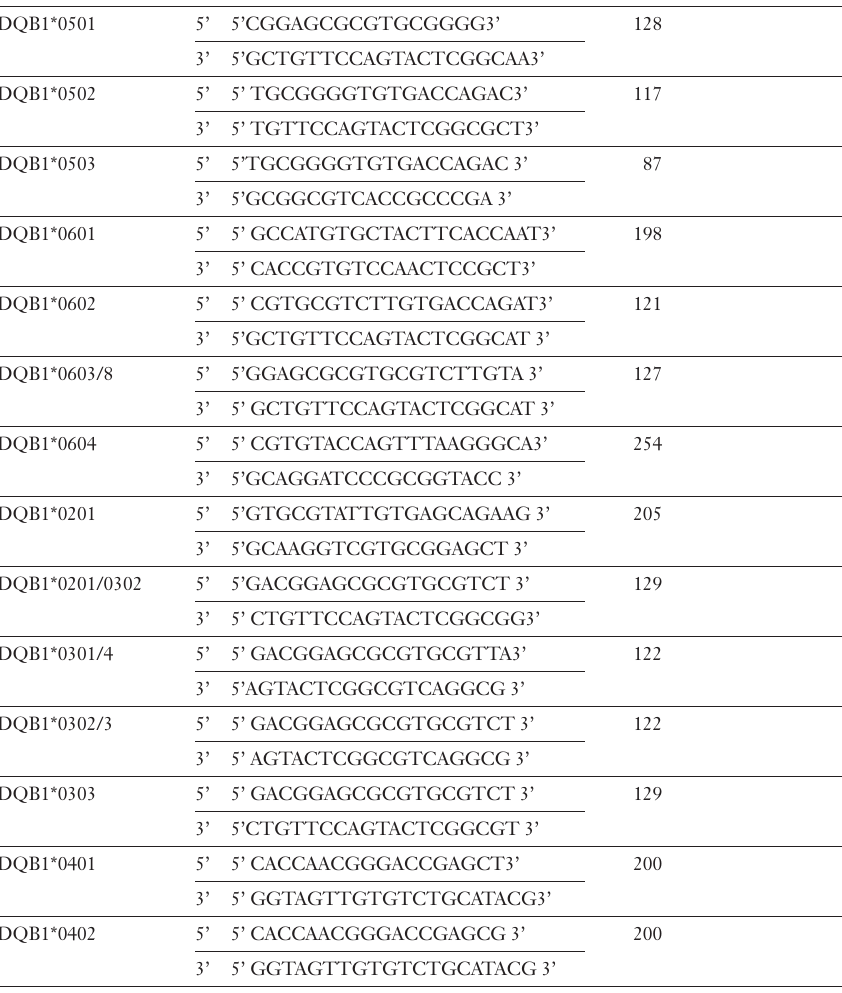
Outline of HLA-DQB1 allele